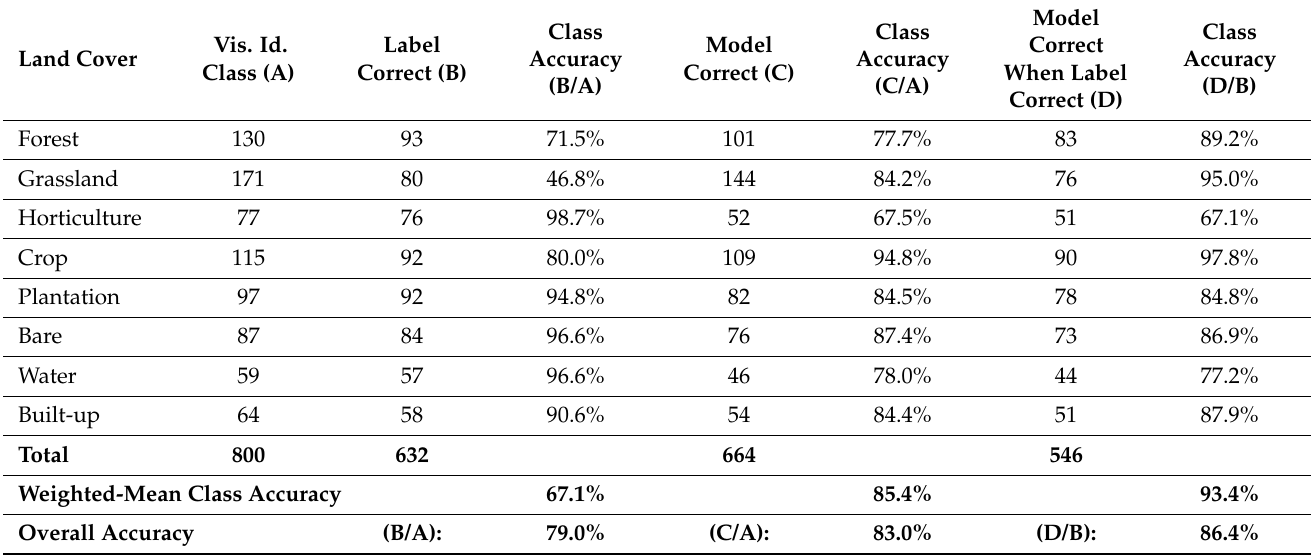
Table 4. Impact of label data errors on model accuracy. Totals and metrics in bold.